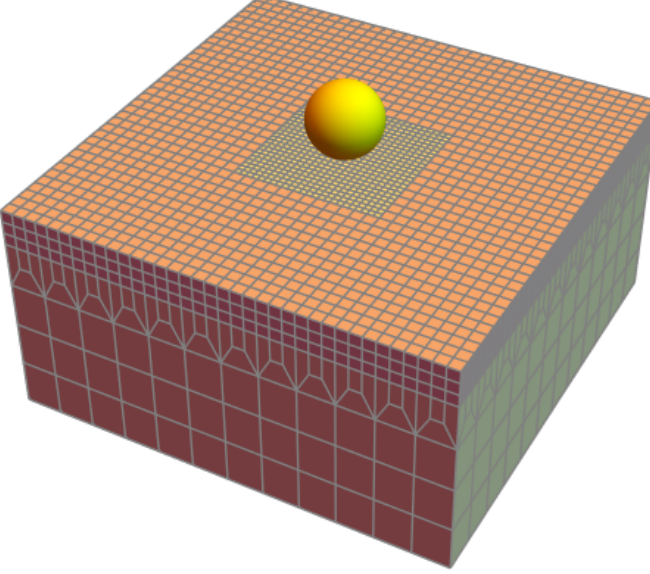
Figure 1. The mesh used for the crystal plasticity finite element